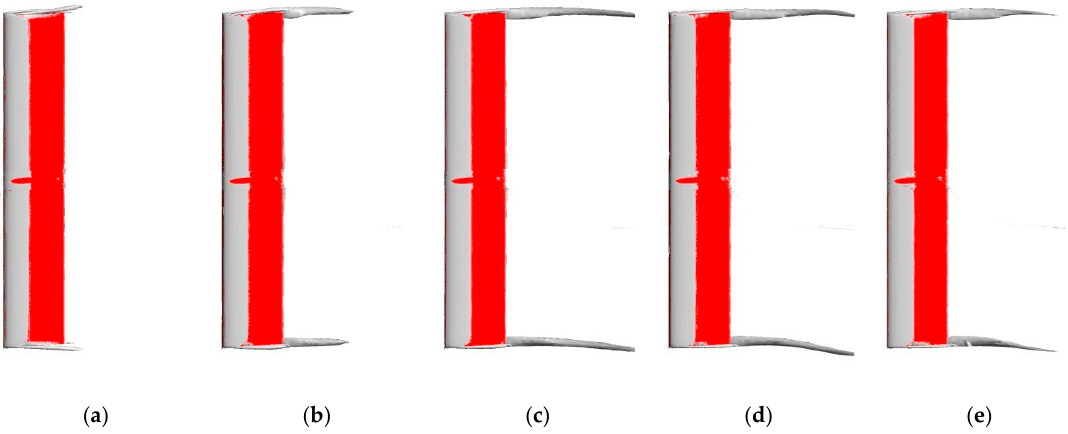
Figure 8. Blade tip vortex under different λ at phase angle of 0°. ( a ) λ = 1.0; ( b ) λ = 1.5; ( c ) λ = 2.0; ( d ) λ = 2.5; and ( e ) λ = 3.0.